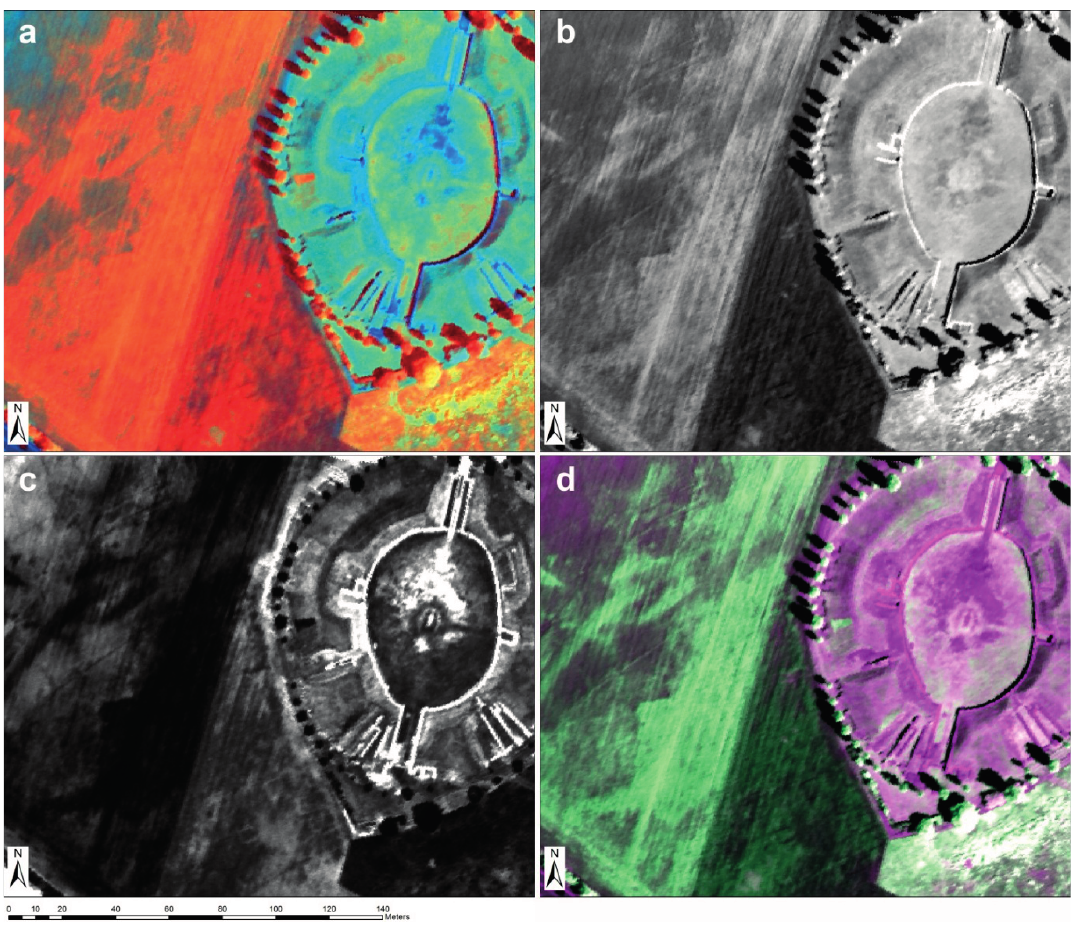
Figure 11. Illustration of the probability distribution fitting (PDF) provided by ARCTIS (see Table 3 for parameter names): ( a ) false color composite of all three parameters of GEV PDF; ( b ) Poisson PDF; ( c ) parameter b of gamma PDF and ( d ) two parameters of normal PDF (in red and